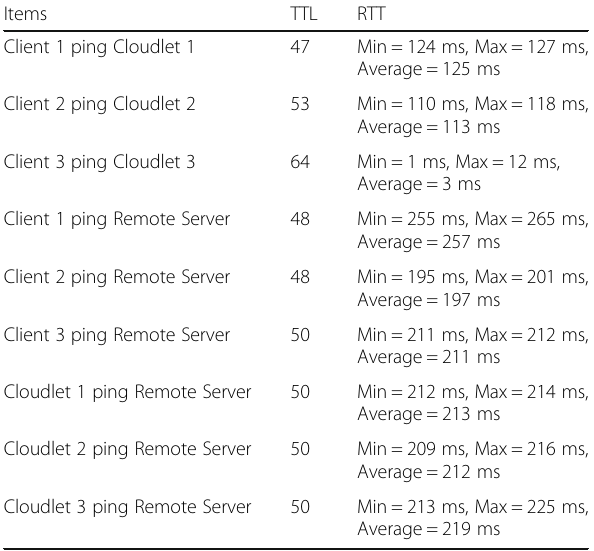
Table 2 Table of experimental details